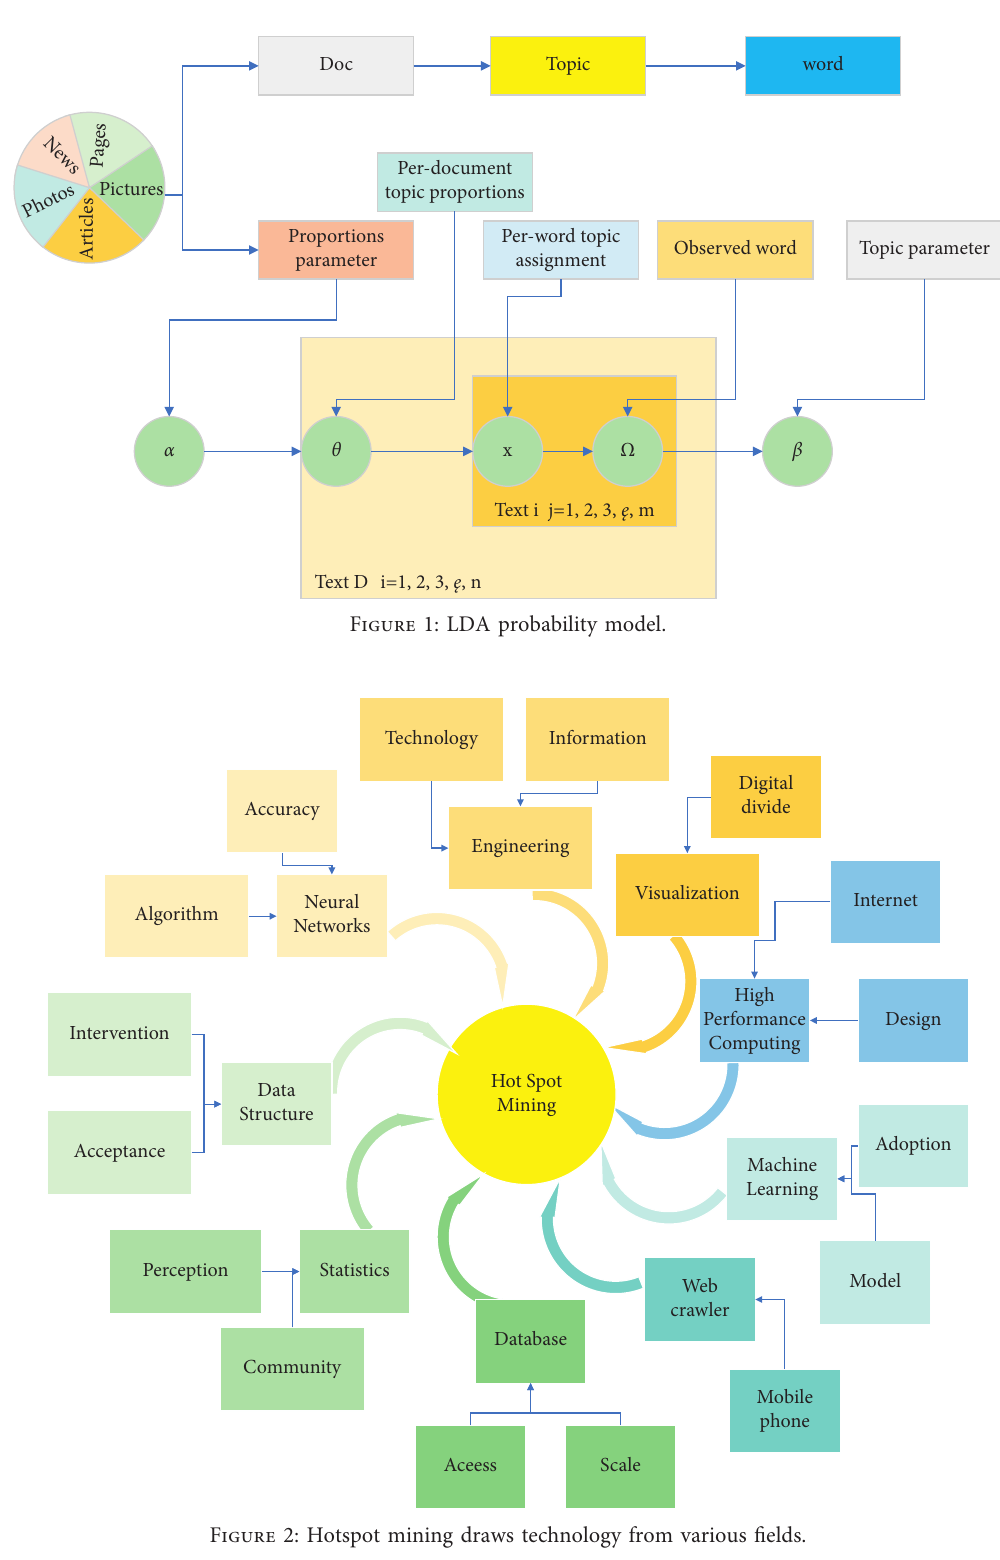
Figure 2: Hotspot mining draws technology from various fields.